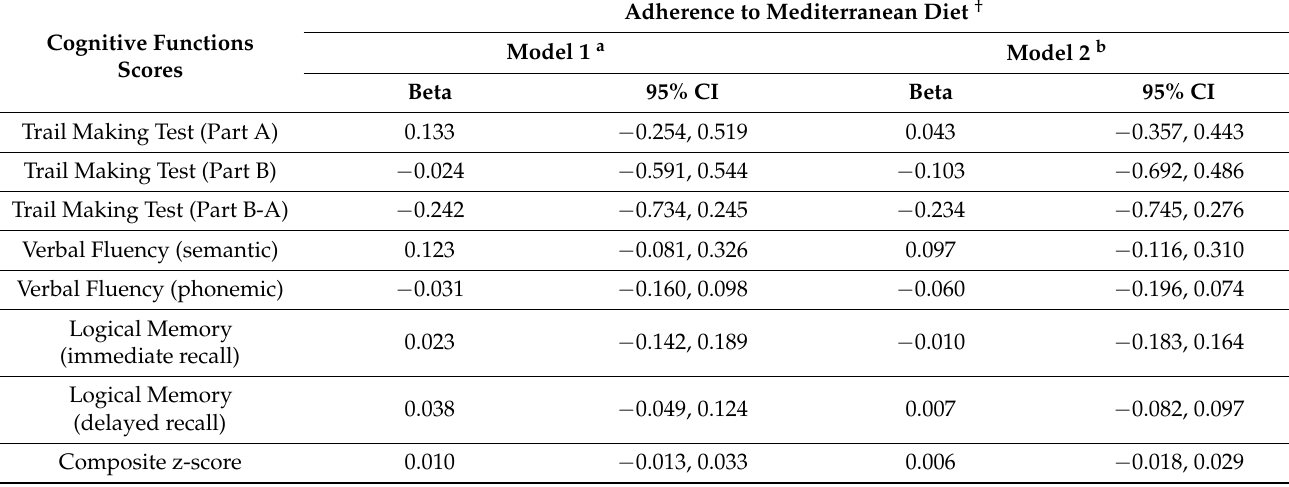
Table 2. Results of multiple linear regressions for the association between adherence to the Mediterranean diet (continuous score) and cognitive function (continuous score) among Epirus Health Study participants.